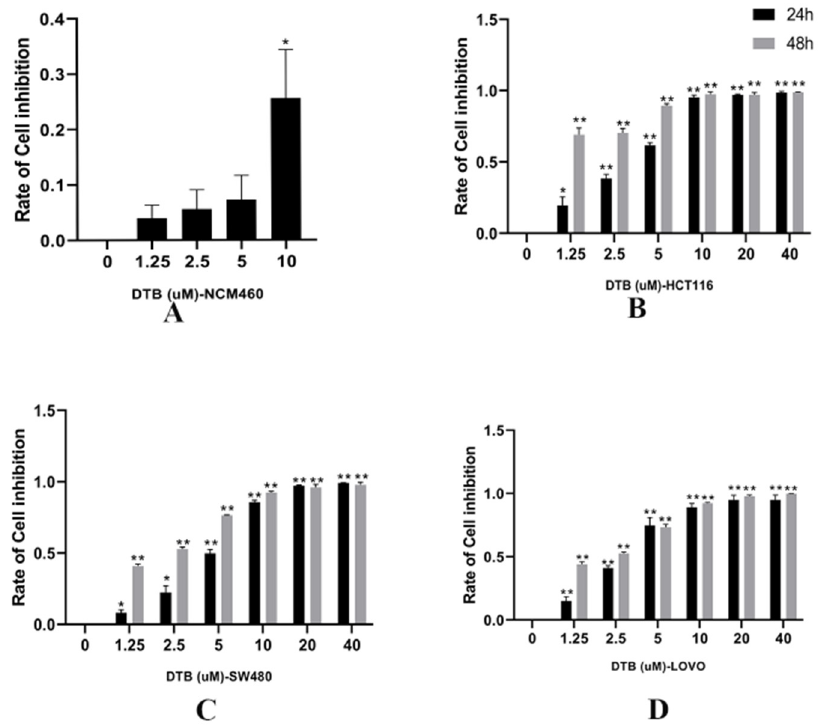
Figure 2. ( A ) The 24 h dose–response curves of DTB on normal human intestinal epithelial cells NCM460. ( B ) The dose–response curves of DTB on HCT116 colon cancer cells for 24 and 48 h. ( C ) The dose-response curves of DTB on SW480 colon cancer cells for 24 and 48 h. ( D ) The dose-response curves of DTB on LOVO colon cancer cells for 24 and 48 h. The abscissa is the DTB concentration and the ordinate is the rate of cell inhibition with the blank control group as a reference. n = 4; each data point represents the mean ± standard error. Compared with the blank group, * p < 0.05, ** p < 0.01.